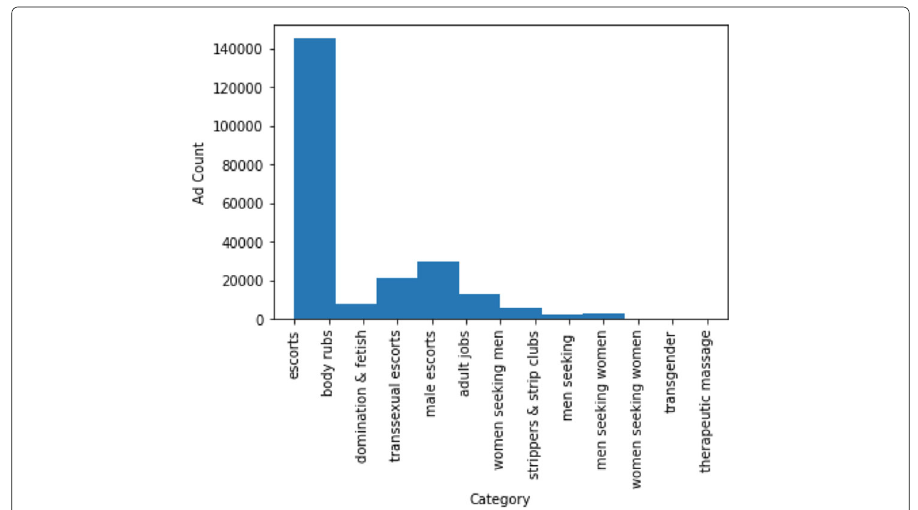
Fig. 4 A distribution of non-zero age ads, broken down by category. The label corresponding to the bar is aligned with its left limit e.g., the first bar refers to ‘escorts’ (with an ad count slightly greater than 140,000).